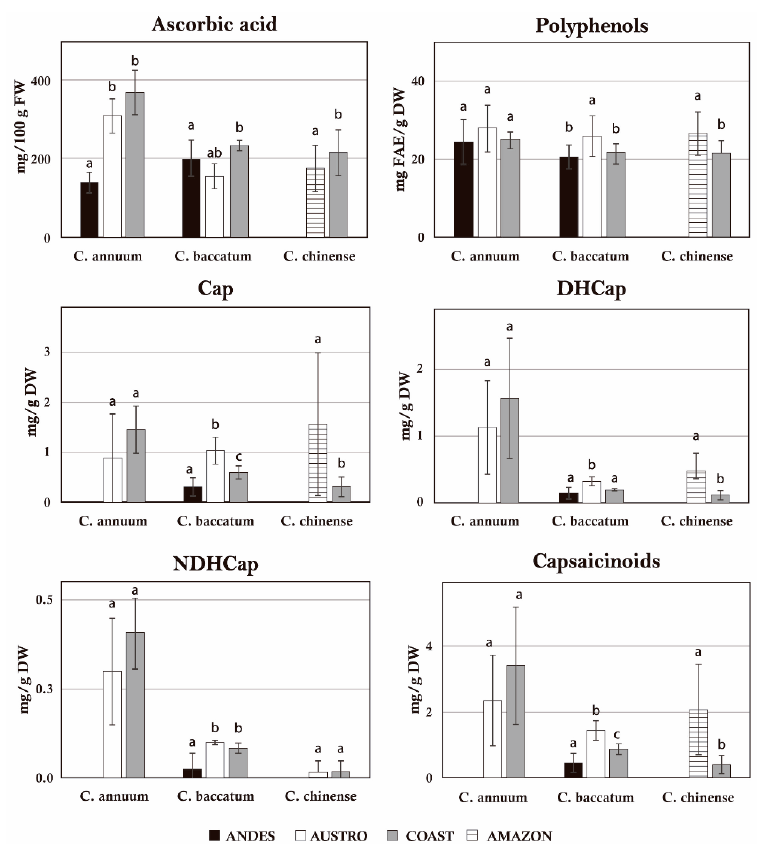
Figure 2. Bar plots of biochemical parameters expressed per region for C. annuum , C. baccatum, and C. chinense . Different letters indicate significant differences at p < 0.05. Only those parameters showing significant differences among regions are represented.